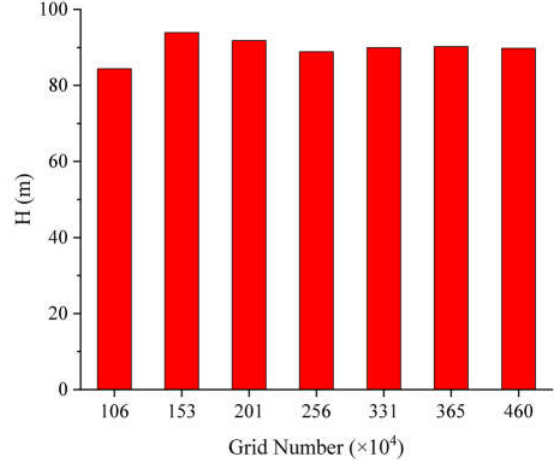
Figure 4. Analysis of independence of grids of the mesh.